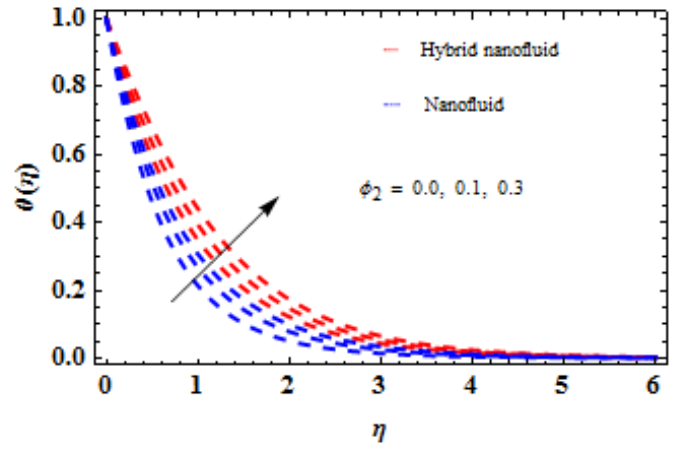
Figure 13. Influence of 𝜙 2 via with 𝜃(𝜂).